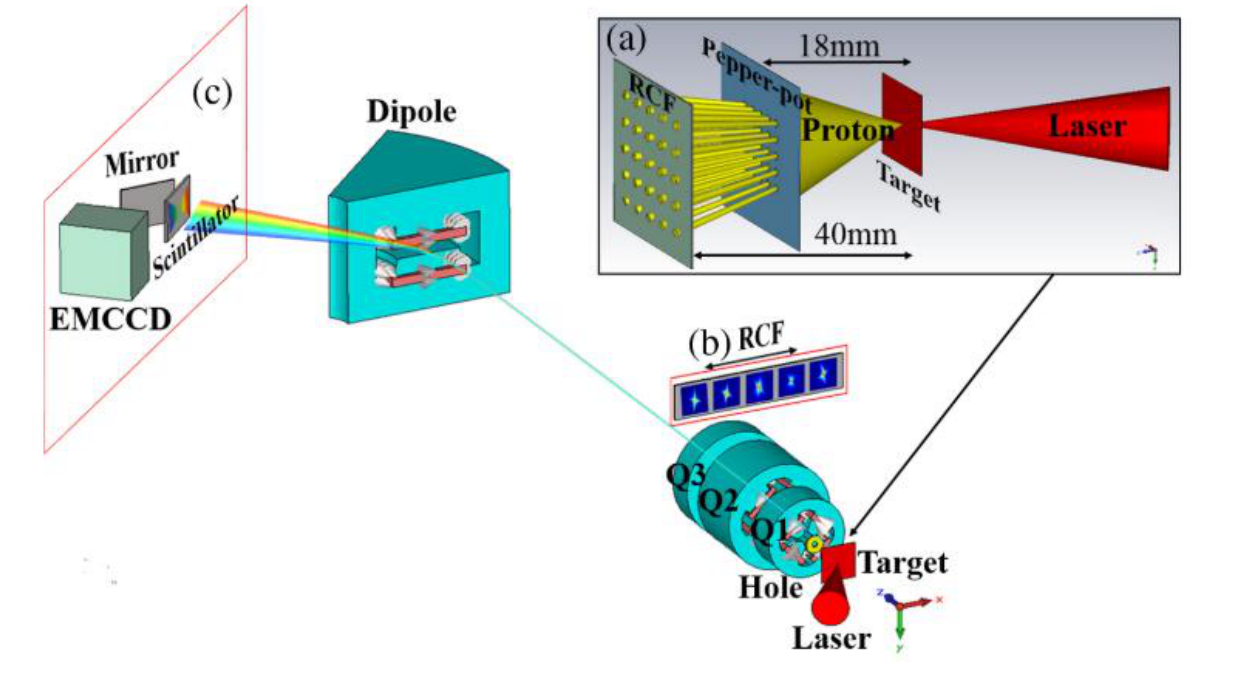
Figure 3. Setup of the emittance measurement experiment on the CLAPA beamline. Protons are accelerated along the z direction, focused by the electromagnetic quadrupole triplet lens, in which Q1 and Q3 focus in the x direction and Q2 focuses in the y direction, and are dispersed by the dipole magnet in the x direction. The following three methods were employed for the emittance measurement [33]: ( a ) pepper-pot; ( b ) quadrupole scan technique; and ( c ) single-shot emittance measurement after the dipole.